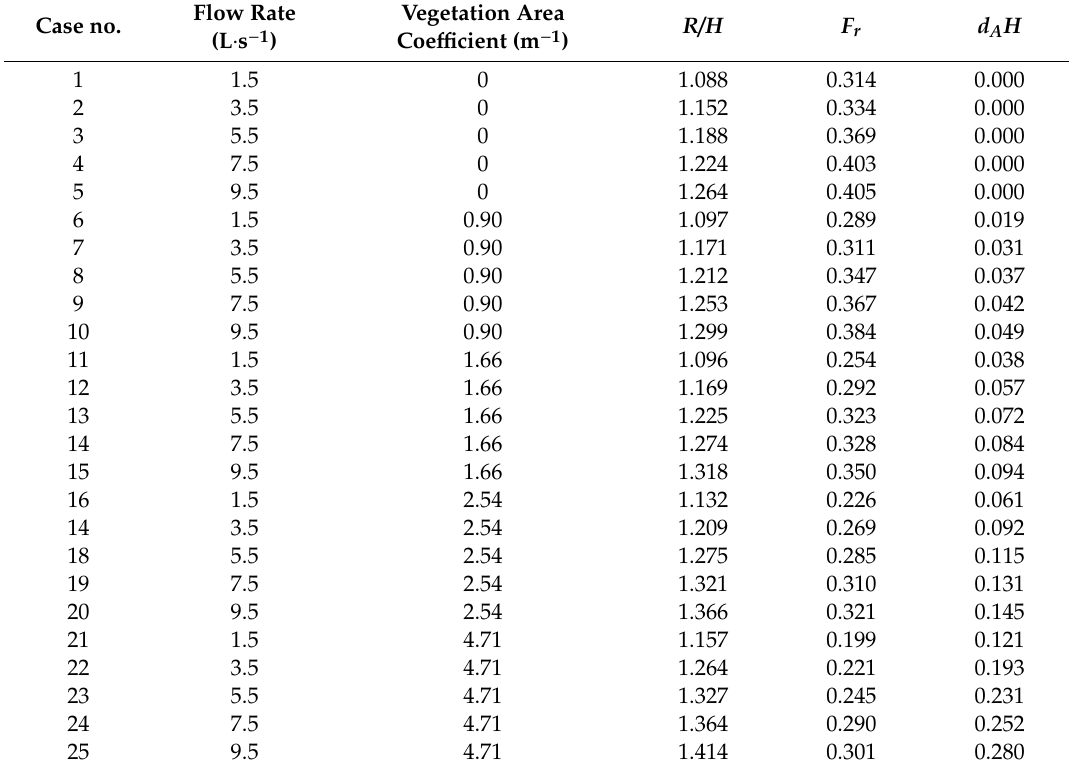
Table 3. Values of the three dimensionless